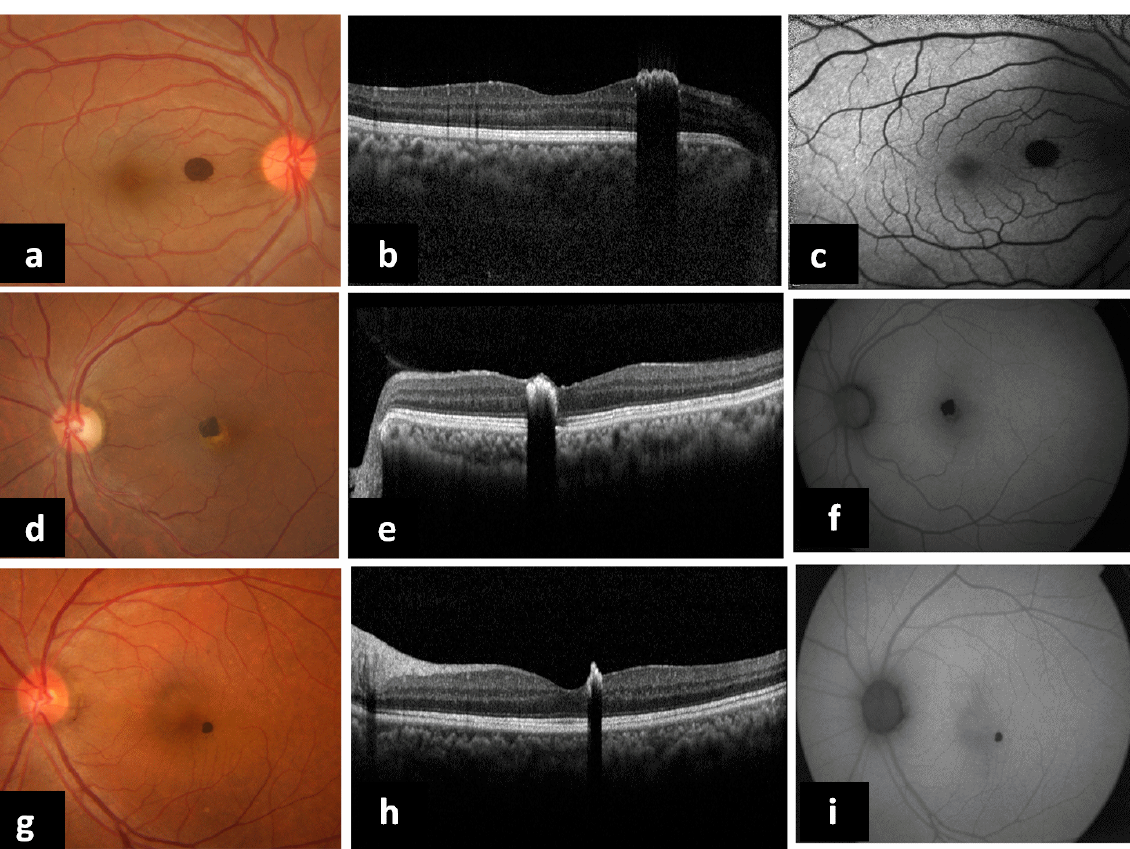
Figure 1: (a, d, g) Fundus photographs of case 1, case 2 and case 3 respectively, showing presumed congenital simple RPE hamartoma close to fovea without any hemorrhage or exudation in the surrounding retina. (b, e, h) EDI-OCT images showing hyperreflective surface of the lesion with total abrupt optical shadowing of the deeper layers. Choroidal thickness is normal. (c, f, i) FAF imaging showing marked, uniform hypoautofluorescence of the lesions with isoautofluorescent perimeter.